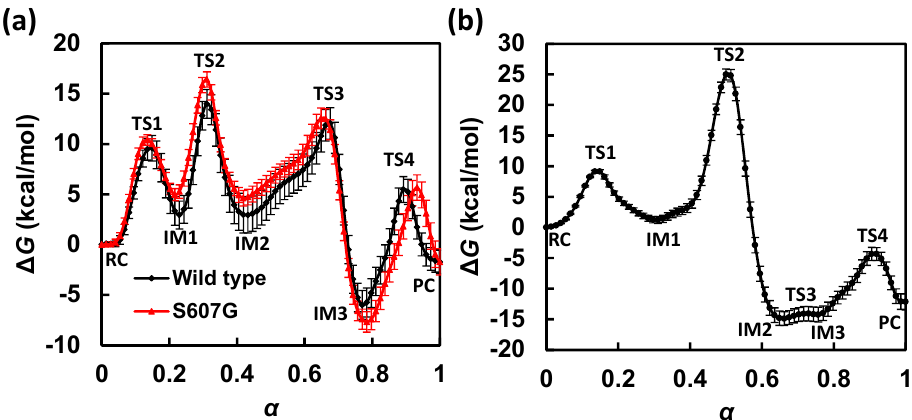
Figure 3. Comparison of free energy profiles along the minimum free energy paths (MFEPs) for ( a ) the GAC and ( b ) the SAC mechanism. The GAC free energy profile for the S607G mutant is also shown in ( a ) as red (grayscale = gray). The statistical fluctuations of free energy are estimated based on the standard deviations of free energy profiles obtained during the last 10 cycles (i.e., cycles 90 to 100) of string path optimization.